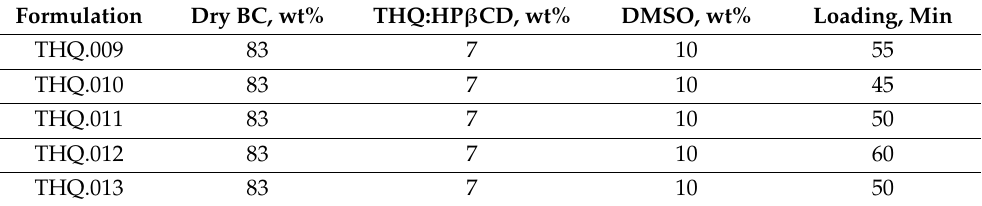
Table 2. Solubility of THQ:HP β CD in BC with co-solvent DMSO at a mixing temperature of 80 ◦ C. Formulation